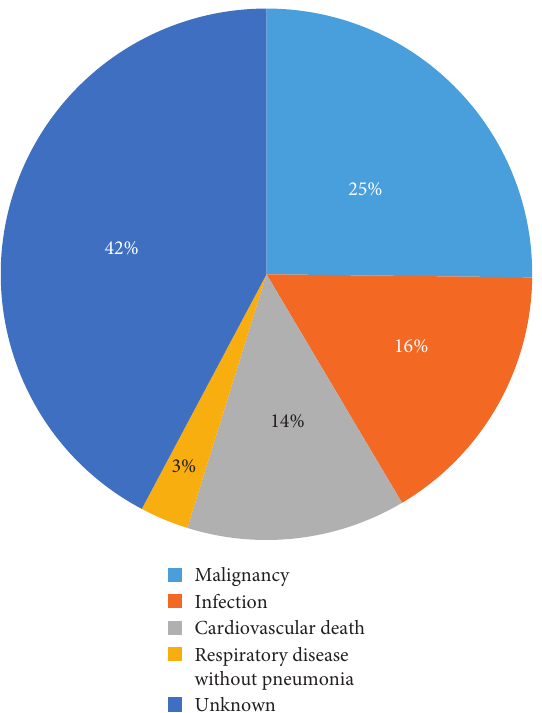
Figure 2: Causes of death for patients with ischaemic heart disease.